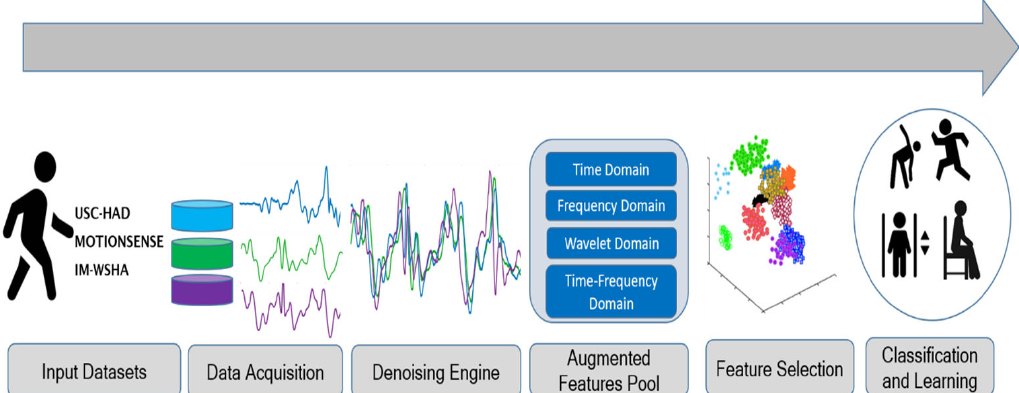
Figure 1. The proposed architecture of the HPAR system.